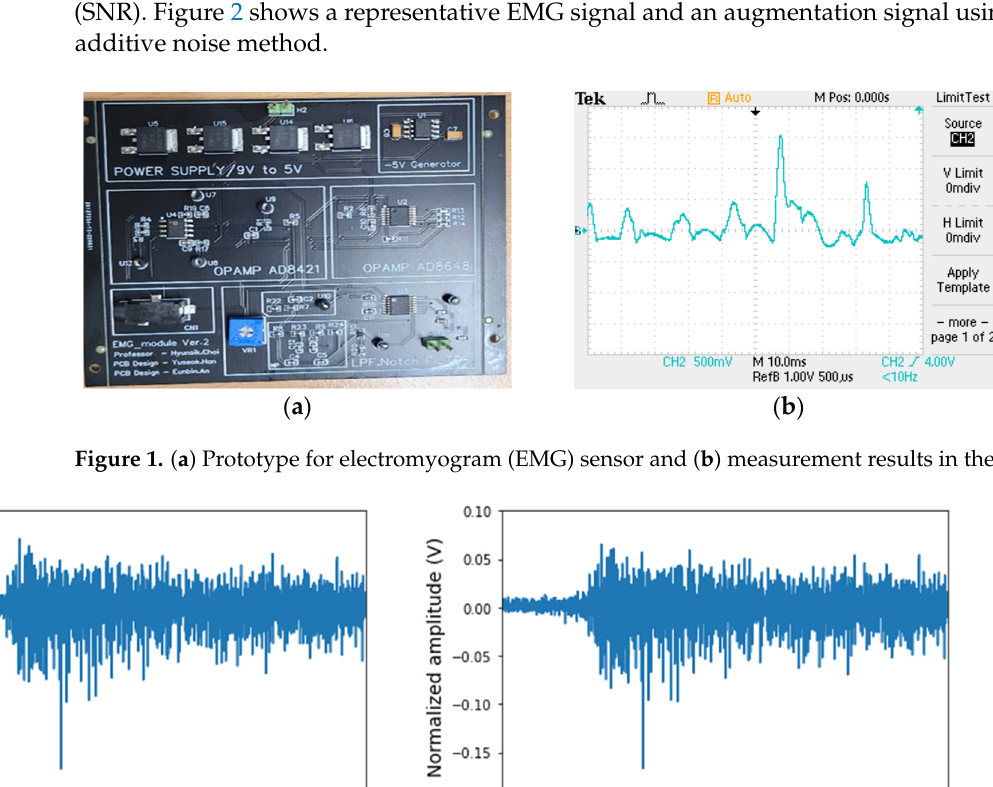
Figure 1. ( a ) Prototype for electromyogram (EMG) sensor and ( b ) measurement results in the wrist.